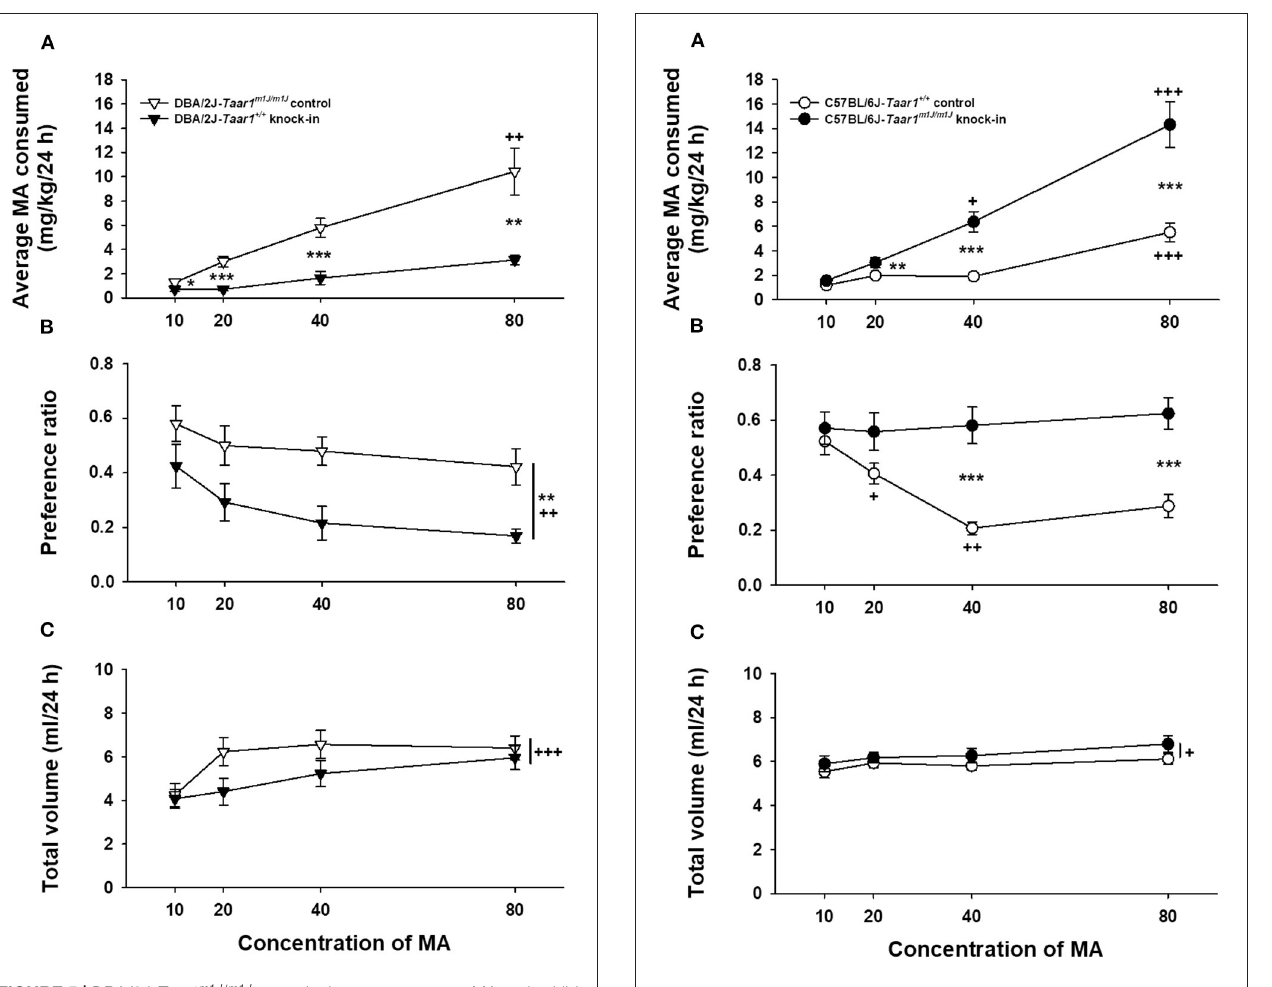
FIGURE 6 | C57BL/6J- Taar1 m 1 J / m 1 J KI mice consume more MA and exhibit greater MA preference than C57BL/6J- Taar1 + / + control mice. Shown are means ± SEM for (A) average MA consumed (mg/kg/24h), (B) preference ratio (ml from MA tube/total ml consumed), and (C) total volume consumed (ml/24h) during two-bottle choice of water and ascending concentrations of MA. Each concentration was offered for a 4-day period. Total N = 47 (eight mice per sex for the C57BL/6J- Taar1 m 1 J / m 1 J KI; 16 male C57BL/6J- Taar1 + / + control mice, and 15 female C57BL/6J- Taar1 + / + control mice. ** p < 0.01, *** p < 0.001 for the difference between mouse lines; + p < 0.05, ++ p < 0.01, +++ p < 0.001 for the effect of concentration compared to the previous concentration (A,B) or for the main effect of concentration (C) . MA, methamphetamine; Taar1 + / + , homozygous reference trace amine-associated receptor 1 genotype; Taar1 m 1 J / m 1 J , homozygous mutant